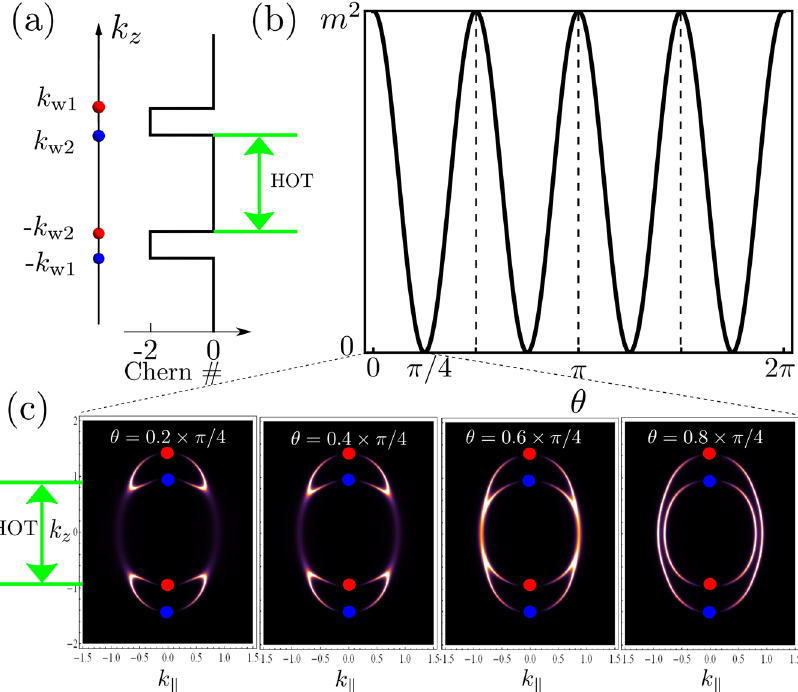
Fig. 3 The location of Weyl points and the orientation-dependent mass term. a Left: The four double-Weyl points on the k z axis. Red and blue dots denote Weyl points with monopole charge + 2 and − 2, respectively. Right: Chern number on k x k y -plane against k z , which changes by ± 2 when a double-Weyl point is passed. It is nontrivial within upper and lower two pairs of double-Weyl points. b The higher-order term m ð θ Þ 2 ¼ m 2 cos 2 ð 2 θ Þ is a periodic function with period π /2. c Angular dependence of Fermi arcs in the range of [0, π /4], which is between Fig. 2b and c. The parameters are A = 1, M 0 = 4.5, t = 1, ϵ = 0.2, and m =